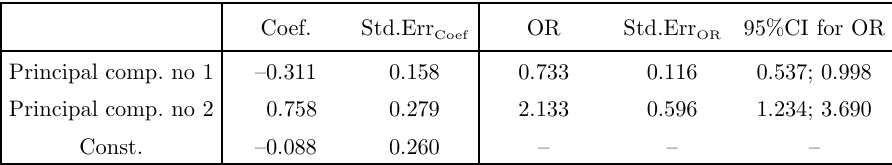
Table 11. Results of the logistic regression approach